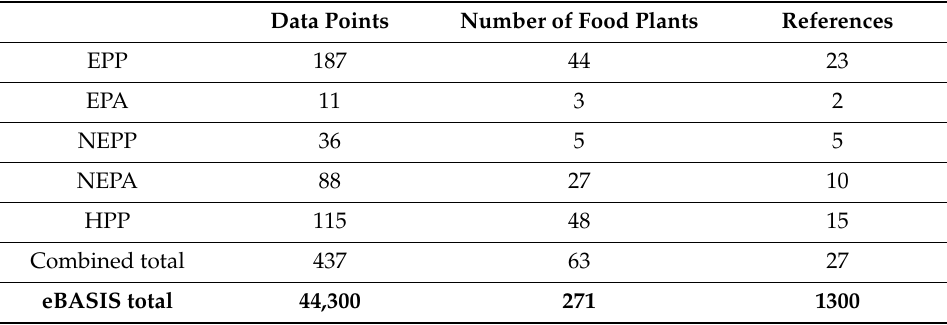
Table 2. Data included within eBASIS database. Data Points Number of Food